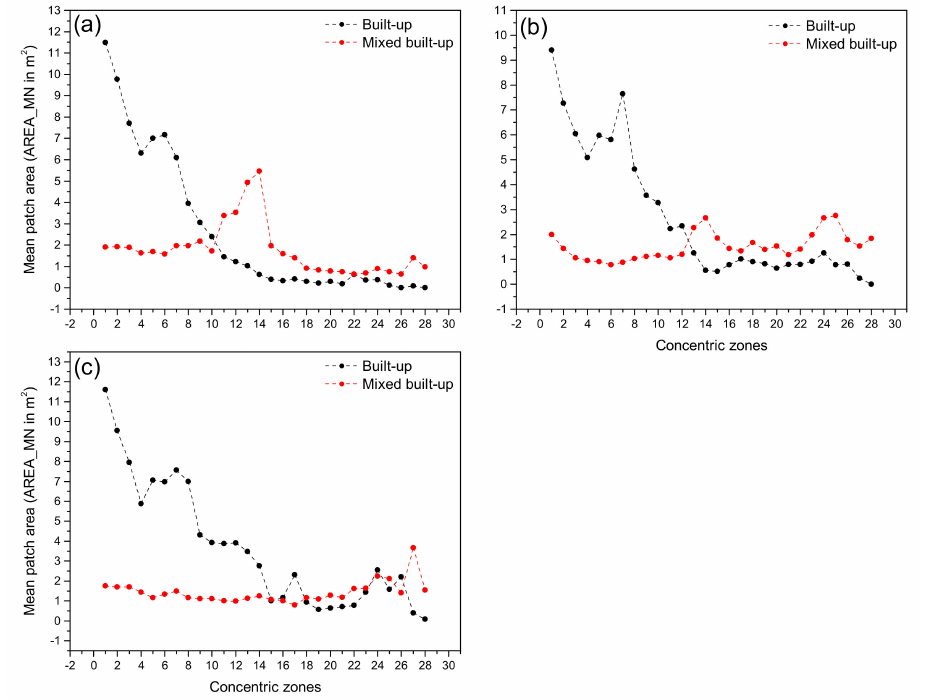
Figure 19. Pattern of AREA_MN plotted against the sequential concentric zones of 1 km each around the river Hooghly within the KMA; the pattern of AREA_MN of built-up and mixed built-up for the concentric zones in ( a ) 1996, ( b ) 2006, and ( c ) 2016.